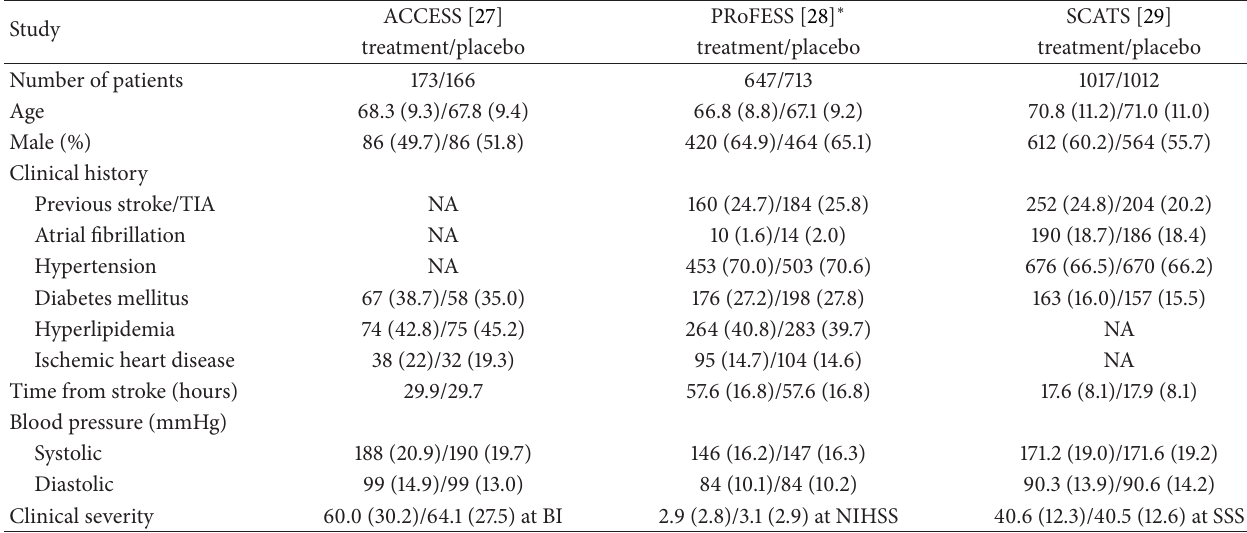
Table 3: Patients characteristics at